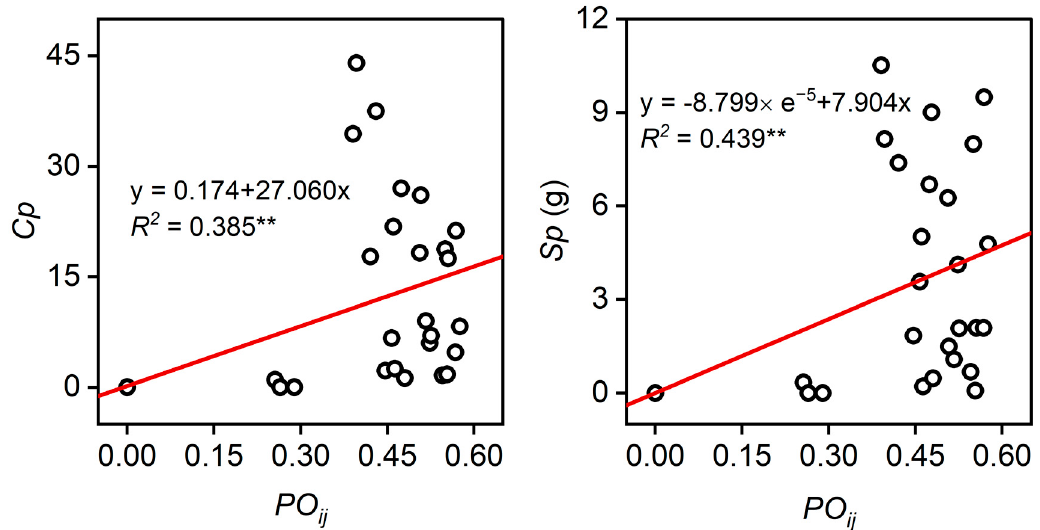
Figure 5. Correlations between the synchronization index and Cp and Sp. Note: ** means a significant difference at the level of 0.01.